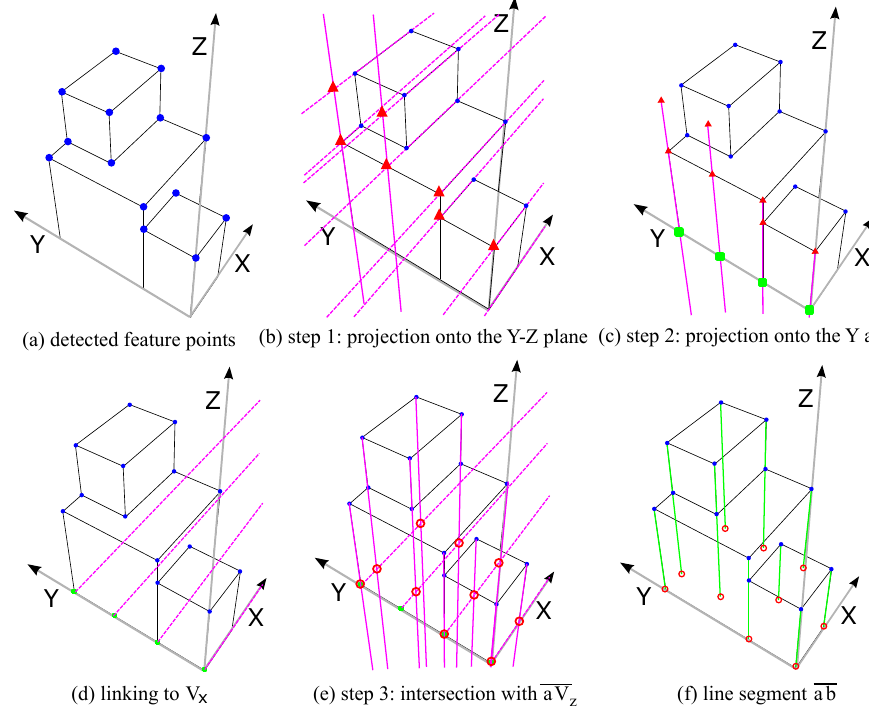
Figure 4. An example procedure of base point prediction. ( a ) Detected feature points (blue dots). ( b ) According to the V x and V z , feature points are projected onto the Y-Z plane. The projections for the feature points are marked in red triangles. ( c ) V z is used to project red triangles onto the Y axis (green squares). ( d ) Green squares are recorded and linked to V x . ( e ) The intersection points of the lines linked from feature points to V z are the base points (red points) corresponding to their feature points. ( f ) Green lines represent the heights between the feature points and base